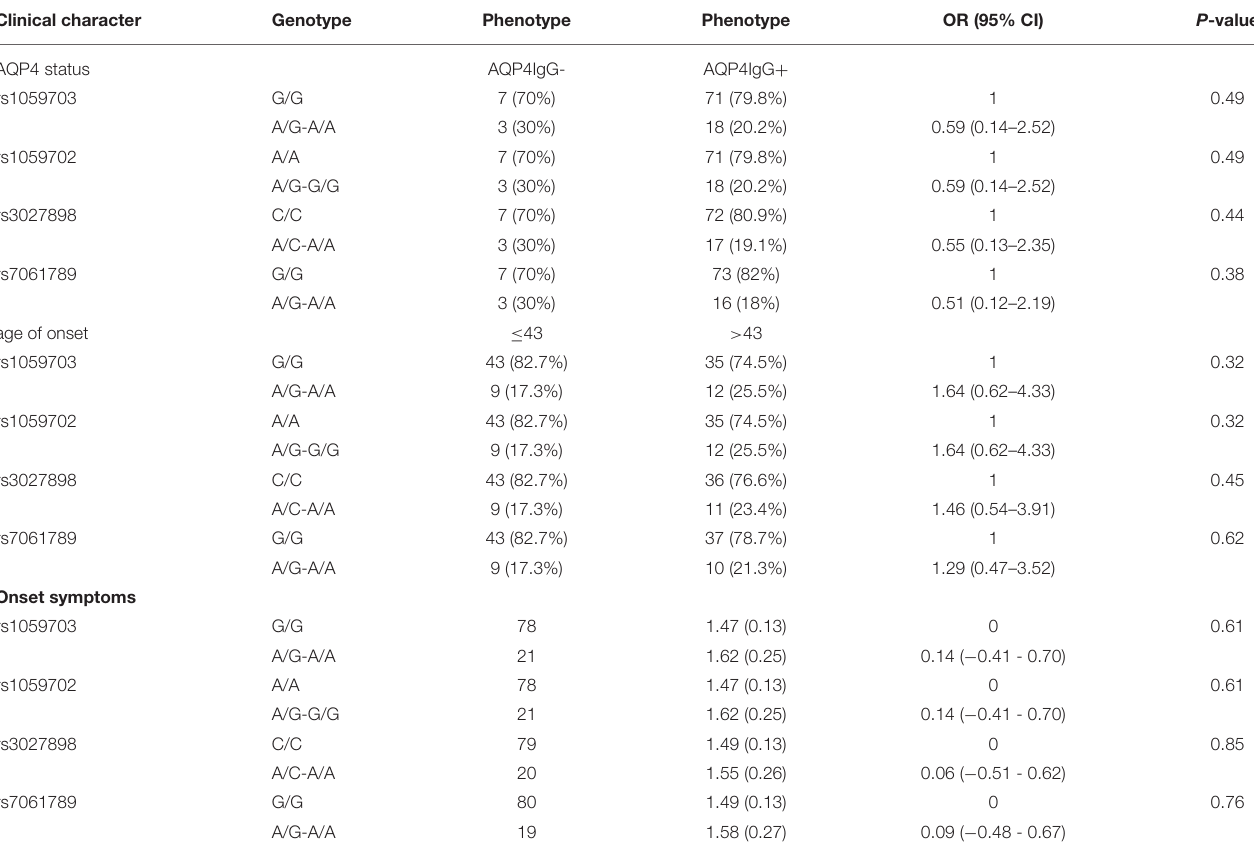
TABLE 7 | Stratified analysis of IRAK1-four SNPs in different clinical features of patients with female